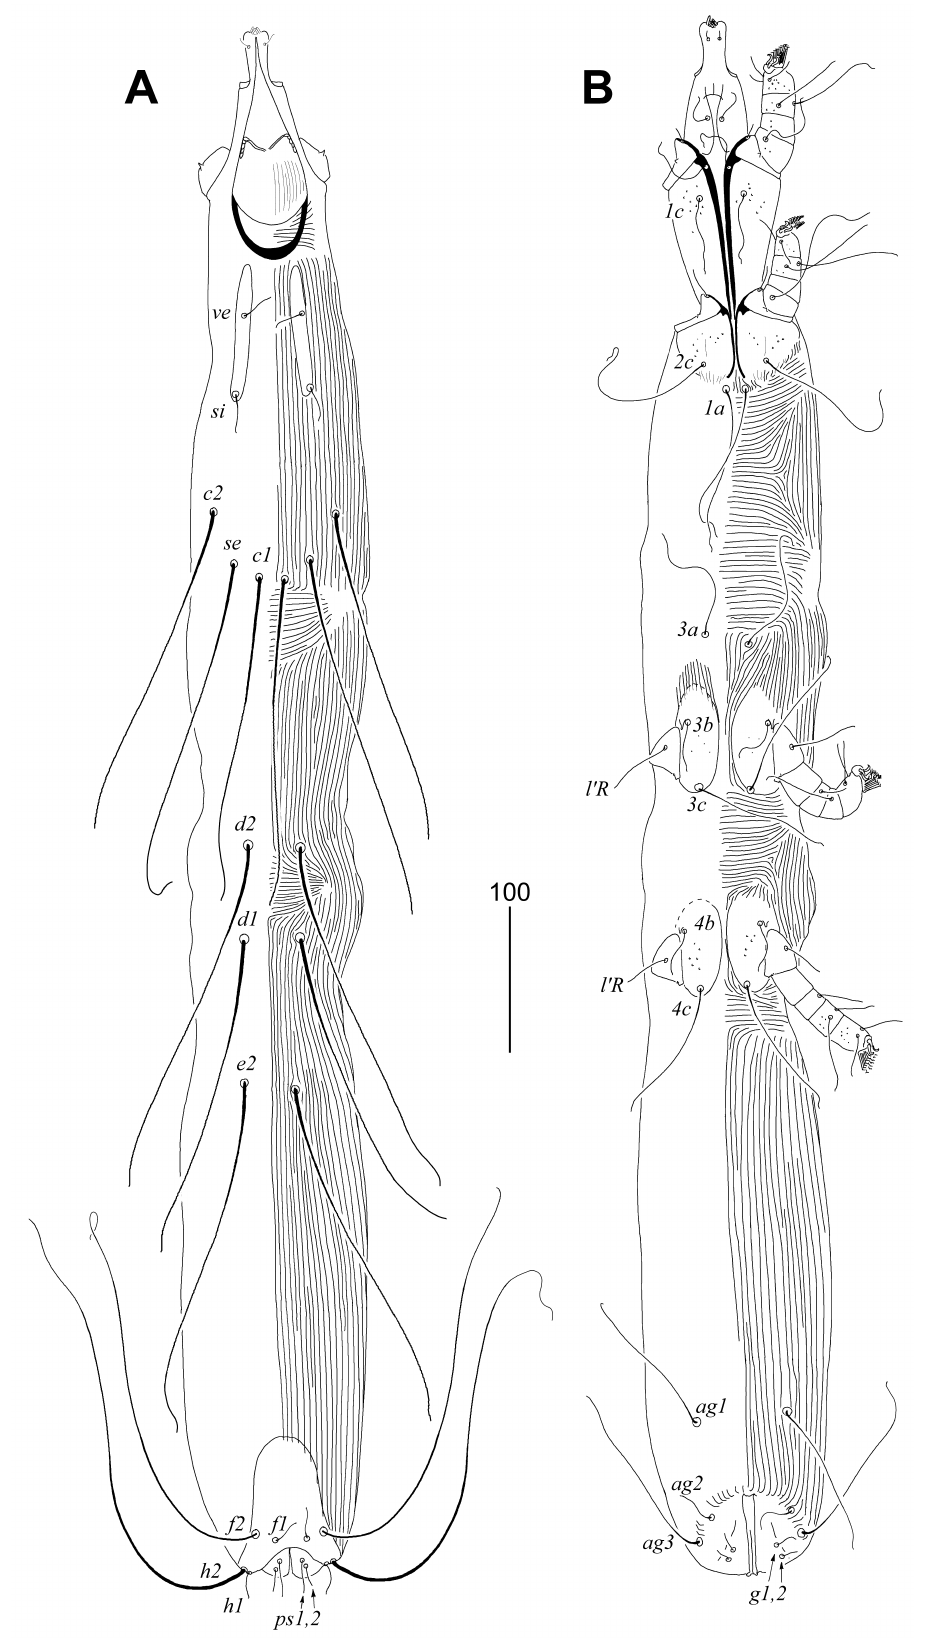
Figure 2. Peristerophila mayri Skoracki and Hromada sp. n., female. ( A )—dorsal view; ( B )— ventral